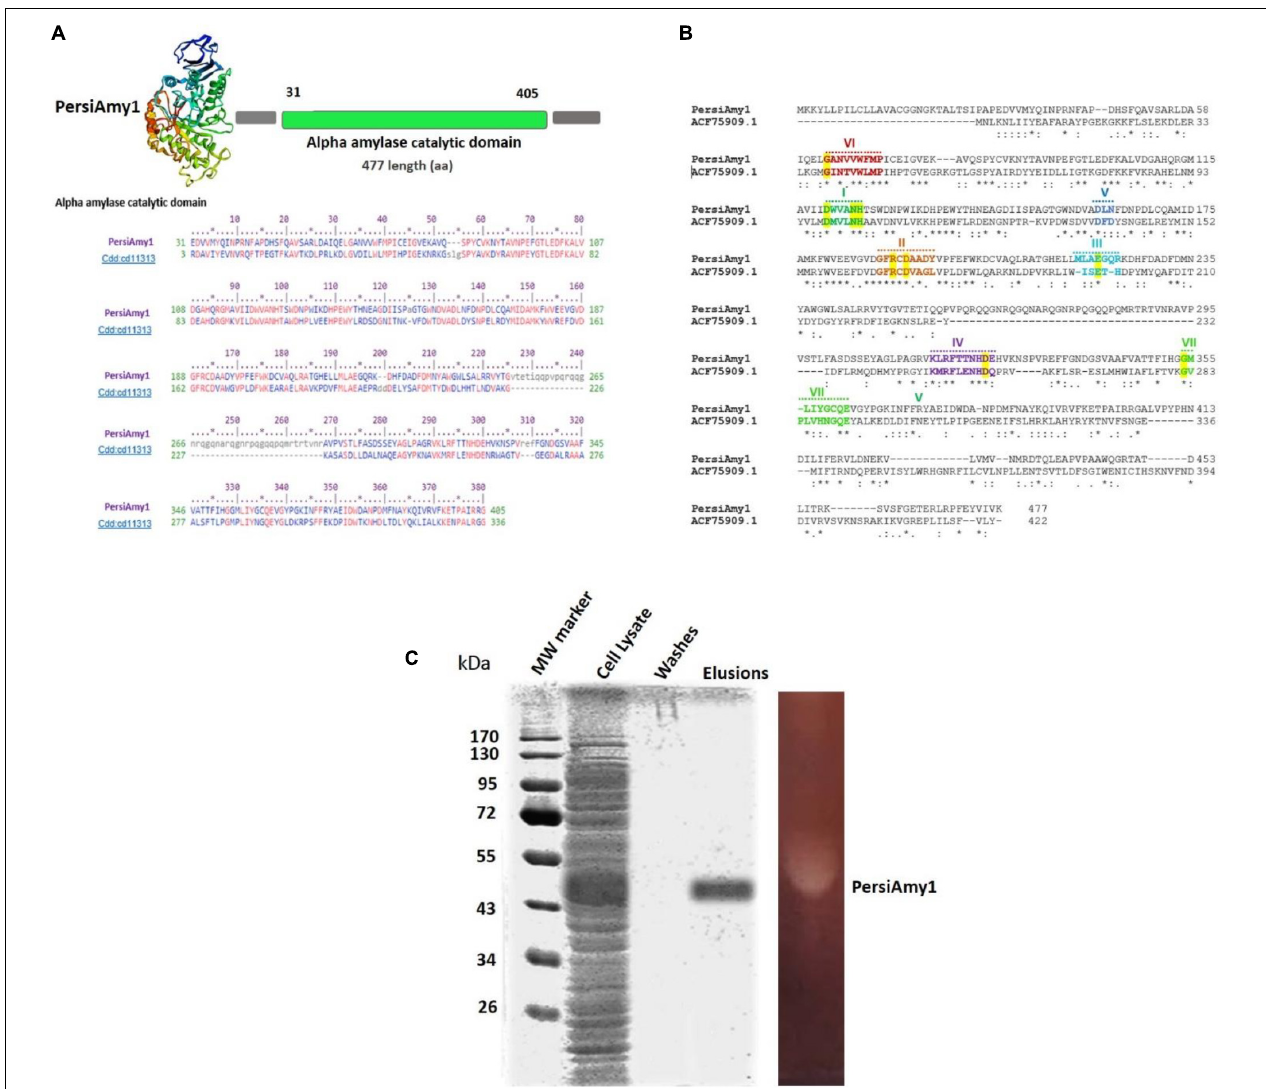
FIGURE 1 | (A) Predicted 3D structure of PersiAmy1 obtained from the Phyre2 prediction server. The Conserved Domains Database (CDD) revealed the active sites and alignment of PersiAmy1 and the pfam00150 and cd14256 catalytic domain. (B) Comparison sequences of PersiAmy1 and Thermotoga neapolitana α -amylases (ACF75909.1) were done. The highly conserved sequences and regions are emphasized by a highlight. (C) Sodium dodecyl sulfate-polyacrylamide gel electrophoresis (SDS-PAGE) and zymogram analysis of